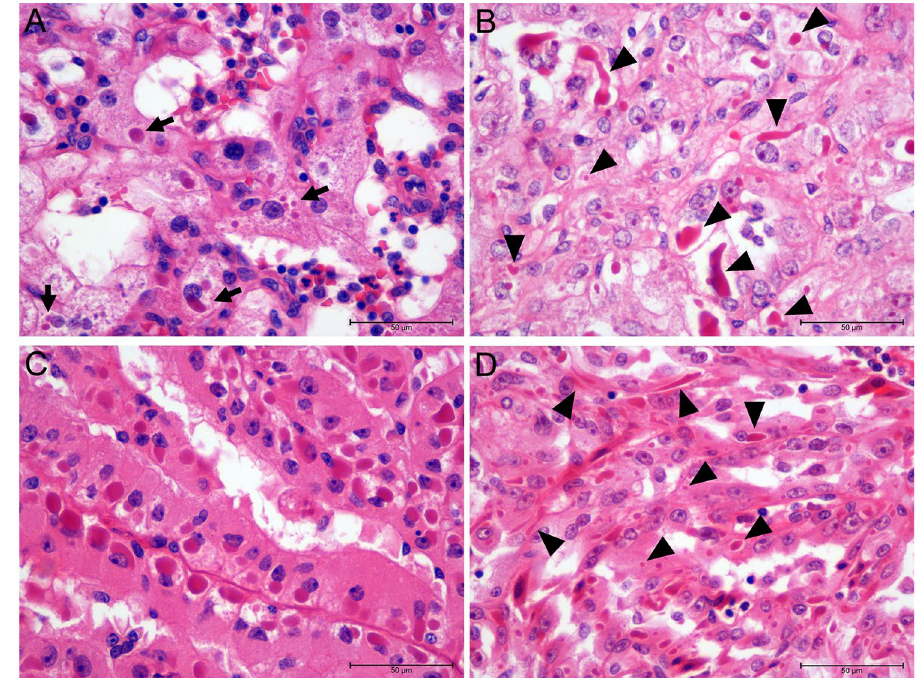
Figure 1. Light microscopic characteristics of ECIs in three types of RCCs (H&E, × 400). ( A and B ) ECIs in ccRCC. Note the variations in the number of ECIs (arrows) and their size (arrowheads) and shape (arrowheads). ( C ) Round-to-oval ECIs were observed to be regularly arranged in a juxtanuclear position in PRCC cells. ( D ) ECIs of varying sizes and shapes (arrowheads) were found in MTSCC